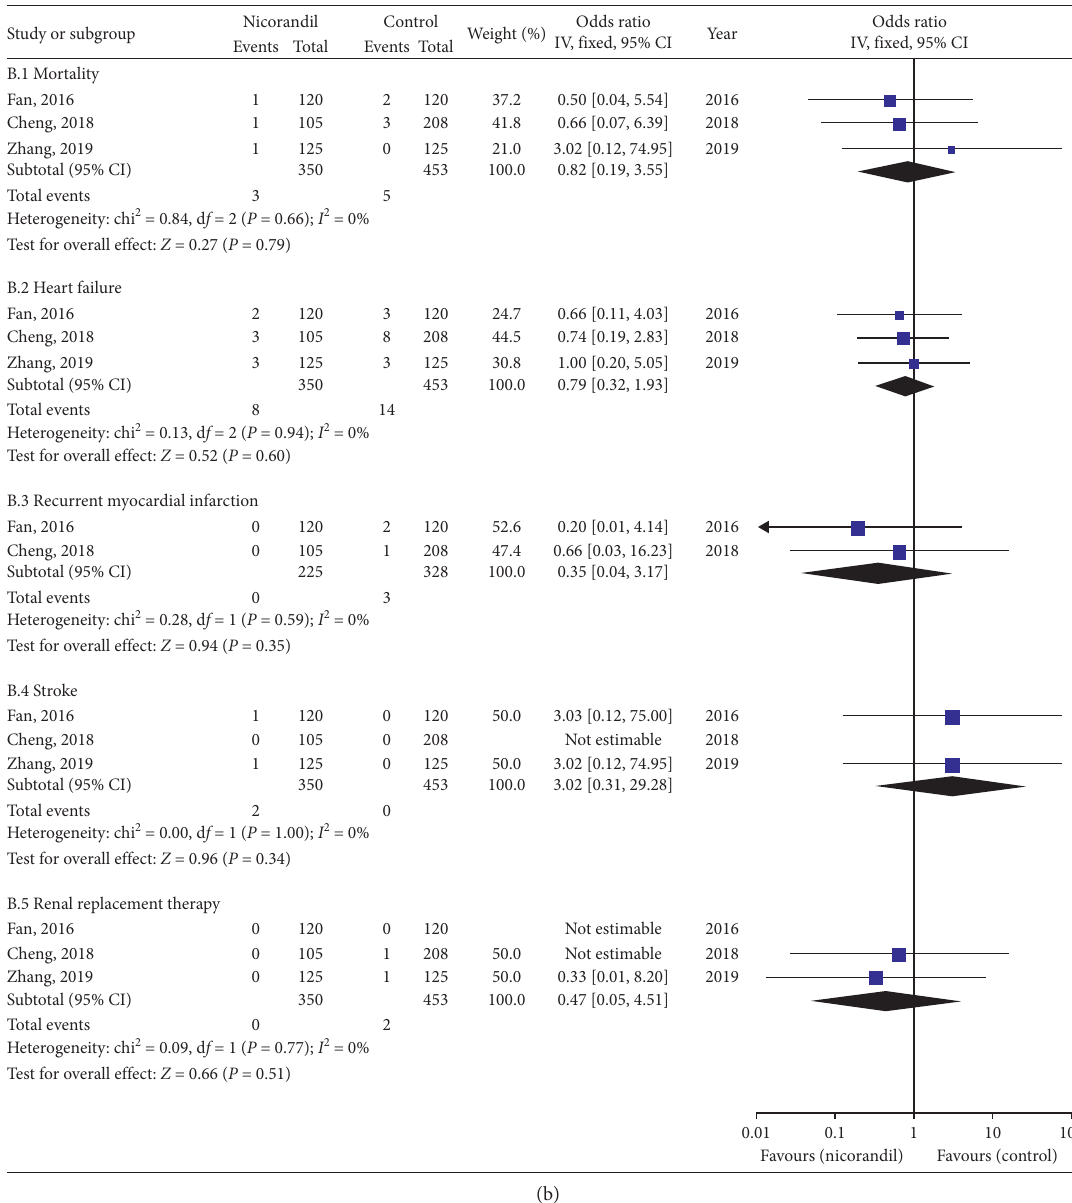
Figure 2: Comparison of nicorandil versus control group for the incidence of (a) contrast-induced nephropathy (CIN) and (b) major adverse events. Abbreviations: IV, inverse variance method; CI, confidence